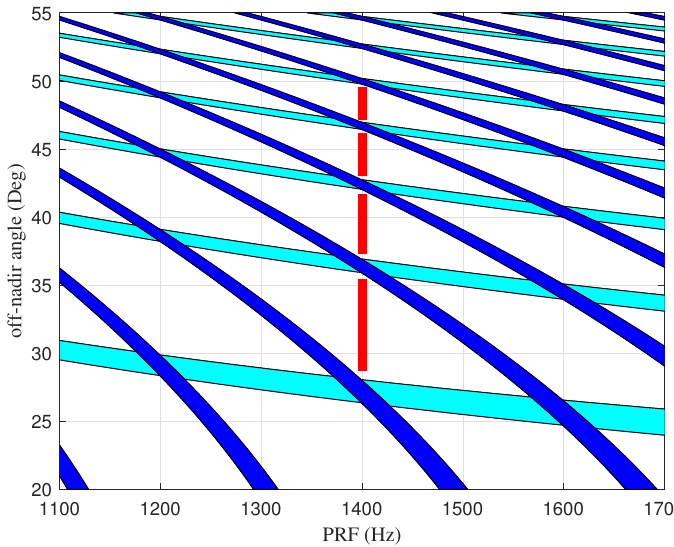
Figure 14. Timing diagram of the simulated STWE-SAR system. Table 2. Information about four sub-swaths. Swath PRF Look Angle 1